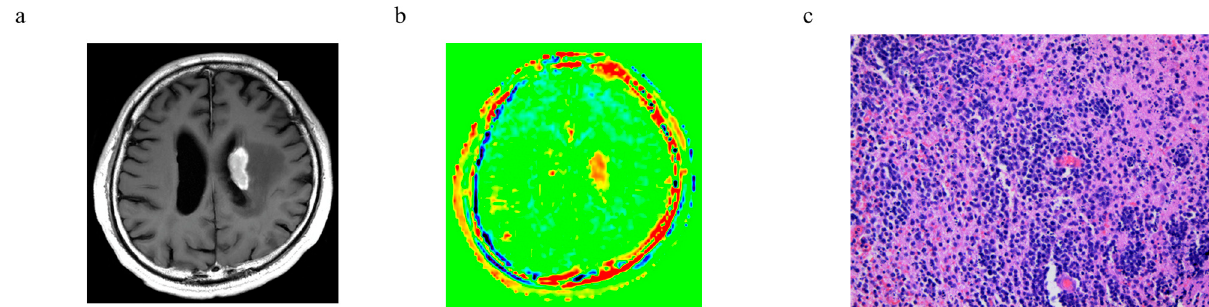
Figure 5. A representative case of PCNSL: ( a ) T1-weighted image with gadolinium, ( b ) APTw image, and ( c ) histology (H–E staining).